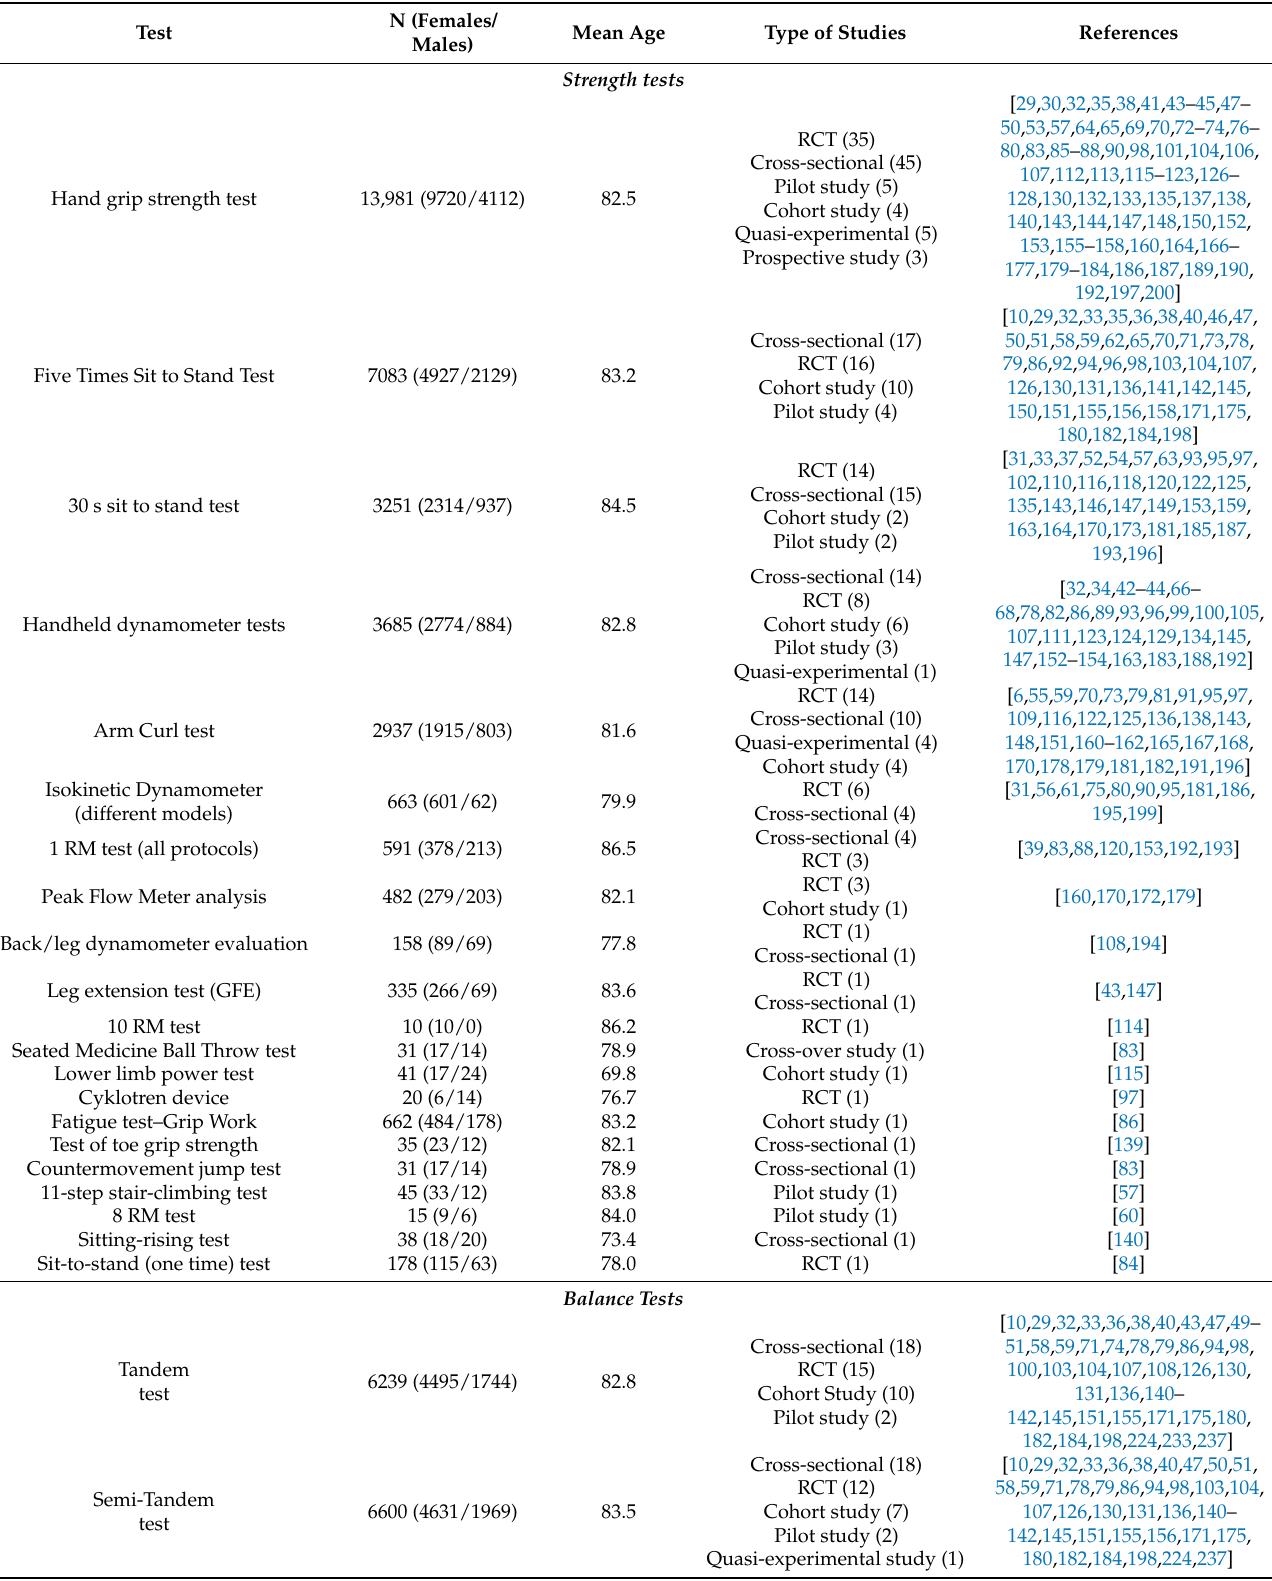
Table 3. Physical and motor tests applied in the reviewed